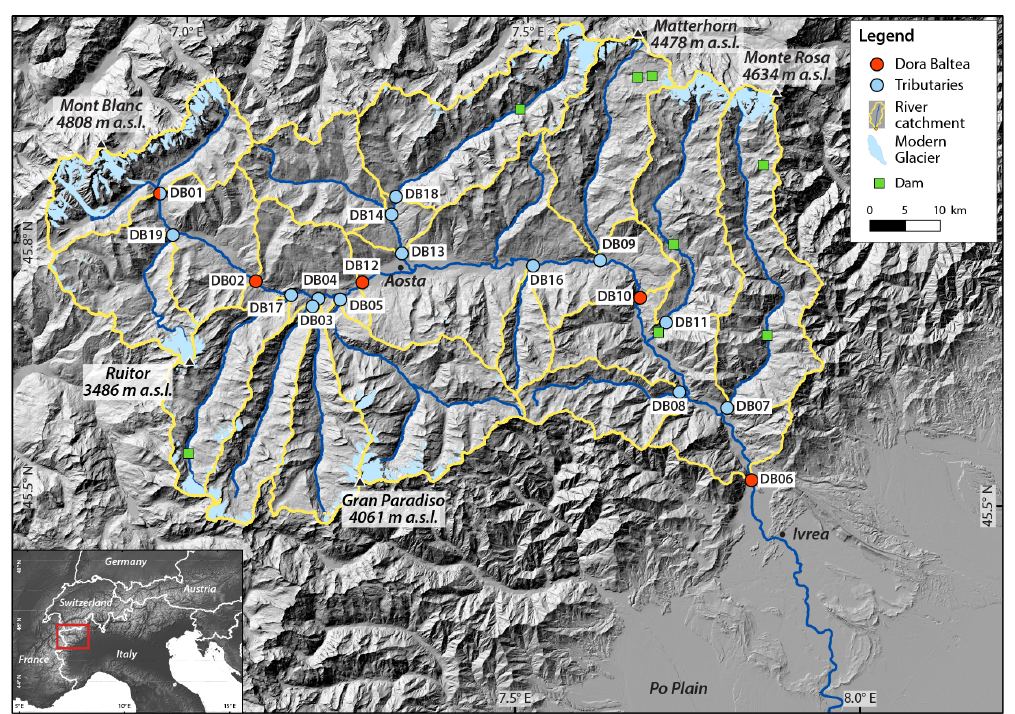
Figure 1. Study area with investigated Dora Baltea and main tributary river catchments (mosaic DEM from Regione Autonoma Valle d’Aosta, Regione Piemonte, swisstopo and Institut Géographique National). Red and light blue circles indicate locations of river-sediment samples collected along the Dora Baltea river and at the outlet of the main river tributaries, respectively (for DB01, red–light blue circle as the sample is located along the Dora Baltea, but it is considered to be an individual tributary). Solid yellow lines delimit the catchments upstream of each sampling location (sample names indicated in the white box). Present-day glaciers (GlaRiskAlp Project, http://www.glariskalp.eu, last access: November 2021), main topographic peaks and dams are indicated. Inset shows location of the DB catchment (open red box) within the European